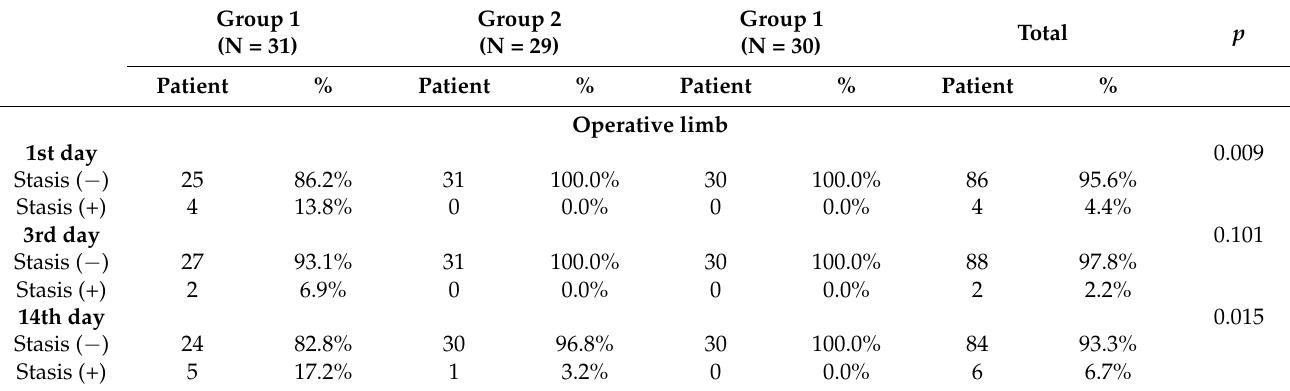
Table 5. Case numbers with stasis after the